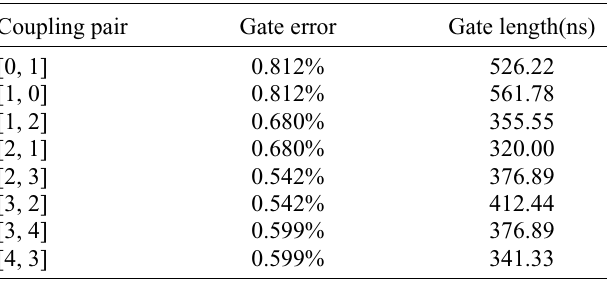
TABLE VI. Two-qubit CNOT gate error and gate length data of the 5-qubit machine ibmq-santiago downloaded from the IBM Quantum system service at the time when the numerical simu- lation is performed. The two-qubit CNOT gate error and lengths are usually different for different two-qubit coupling pairs due to different coupling strength and different qubit frequencies in the qubit